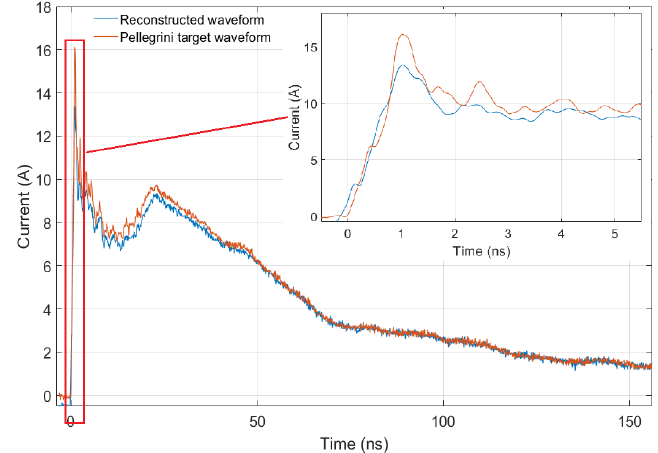
Figure 11. Comparison of the reconstructed waveform applying the proposed methodology with the Pellegrini target (reference) waveform for a +4 kV pulse of the Schaffner NSG 433 ESD generator including a zoomed view of the initial peak. Table 5 . Reconstructed and reference ESD current parameters the Schaffner NSG 438 ESD genera- tor.